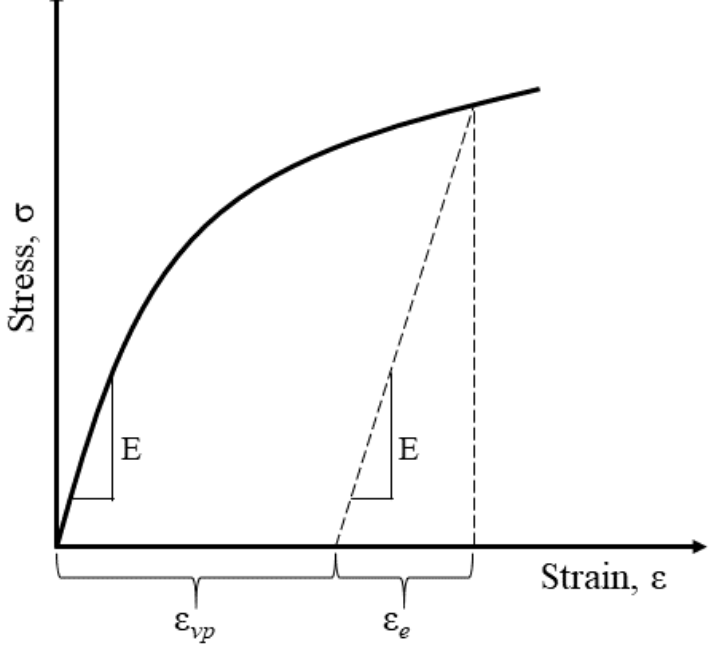
Figure 1. Typical Uniaxial Stress-Strain Response